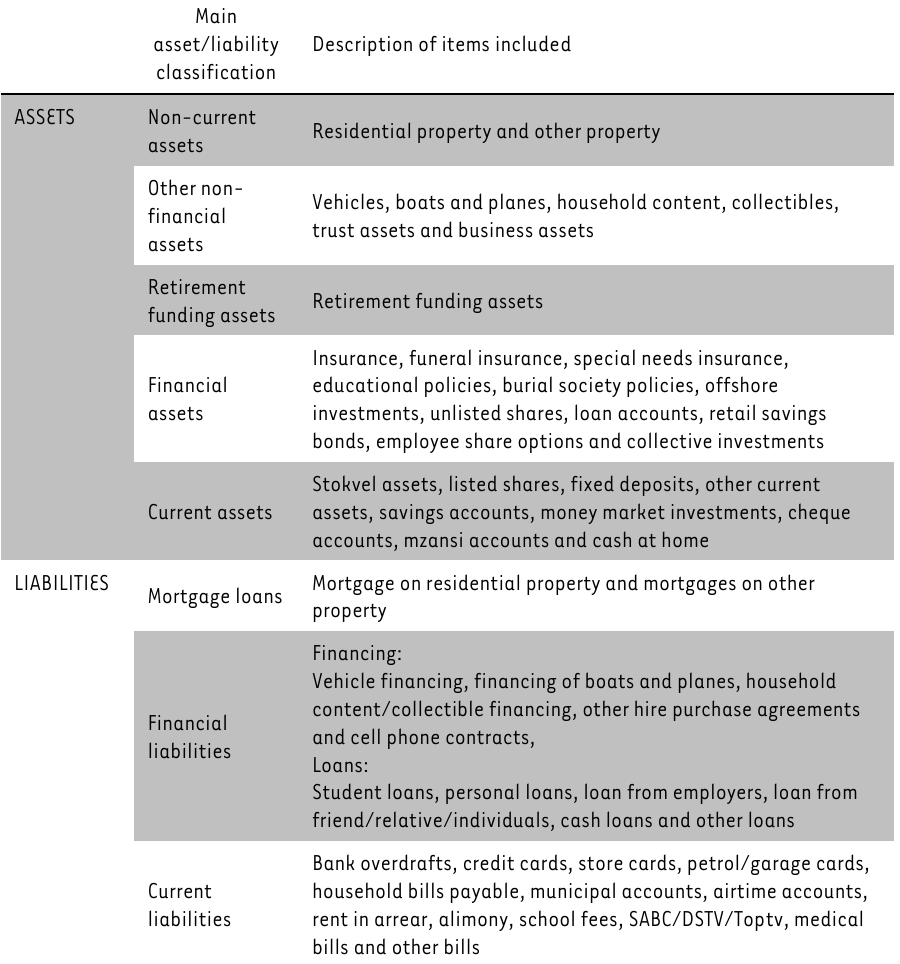
TABLE 1: South African household Statement of Financial Position framework for assets and